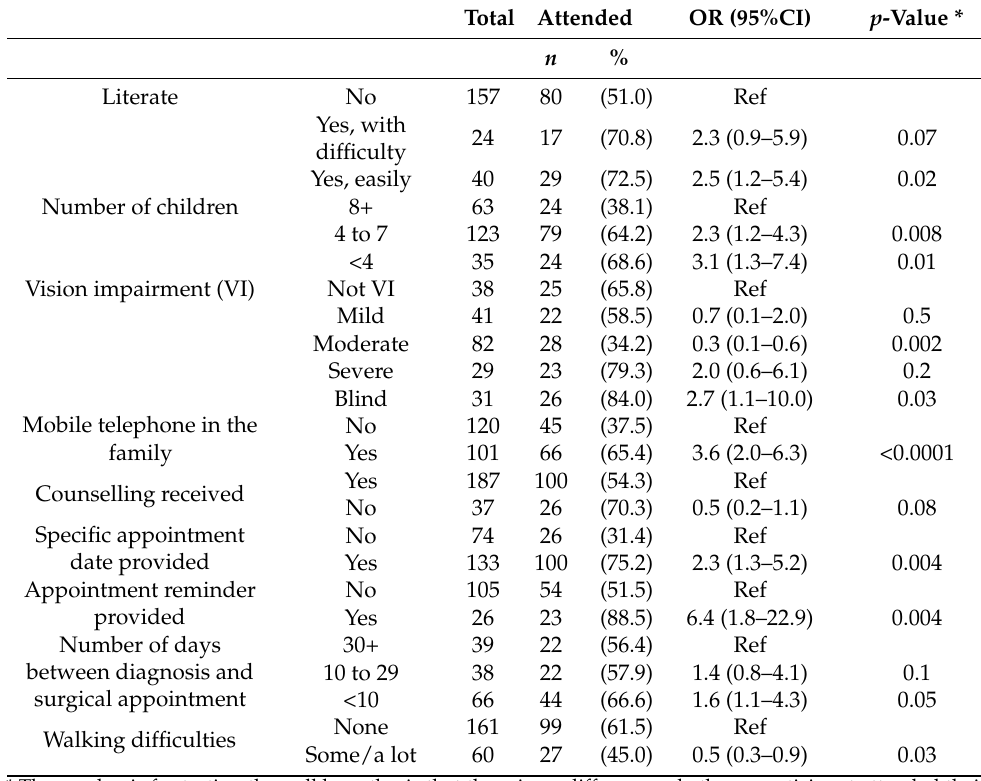
Table 2. Predictors of uptake of cataract surgery in Rwanda, May–July 2019.